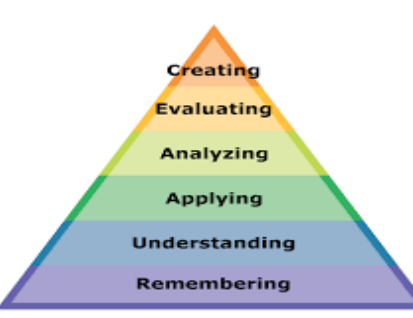
Figure 2a . Bloom’s taxonomy [1]